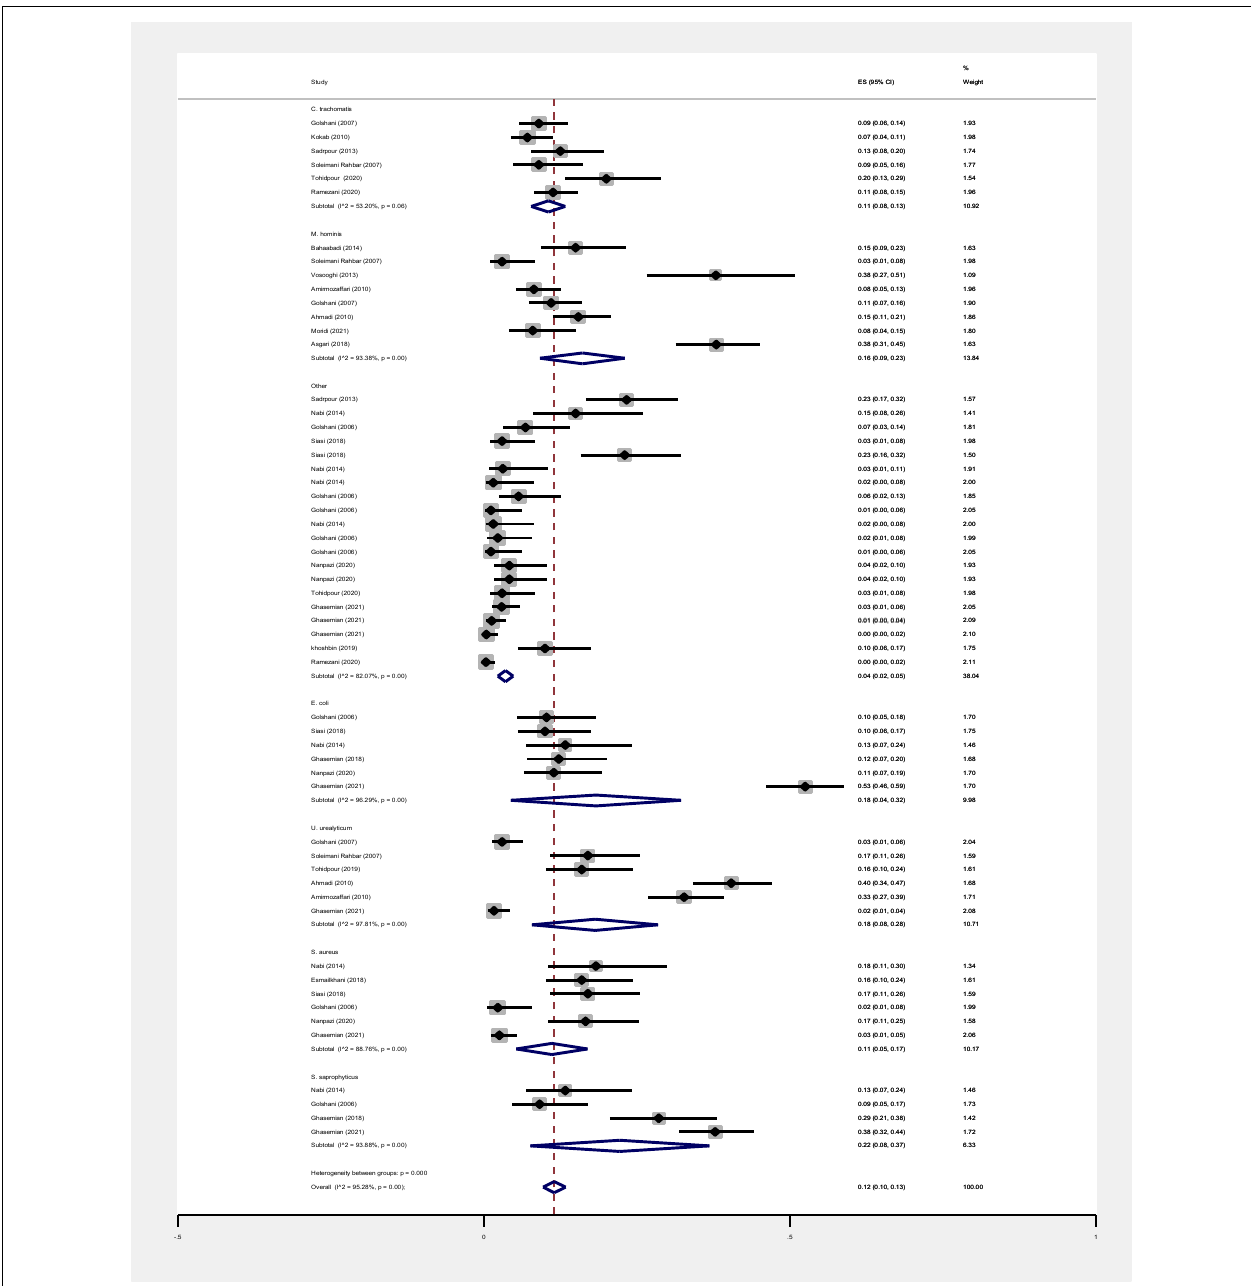
FIGURE 9 | Estimating the prevalence of bacterial agents in each of the initial studies and pooled estimate with a 95% confidence interval.